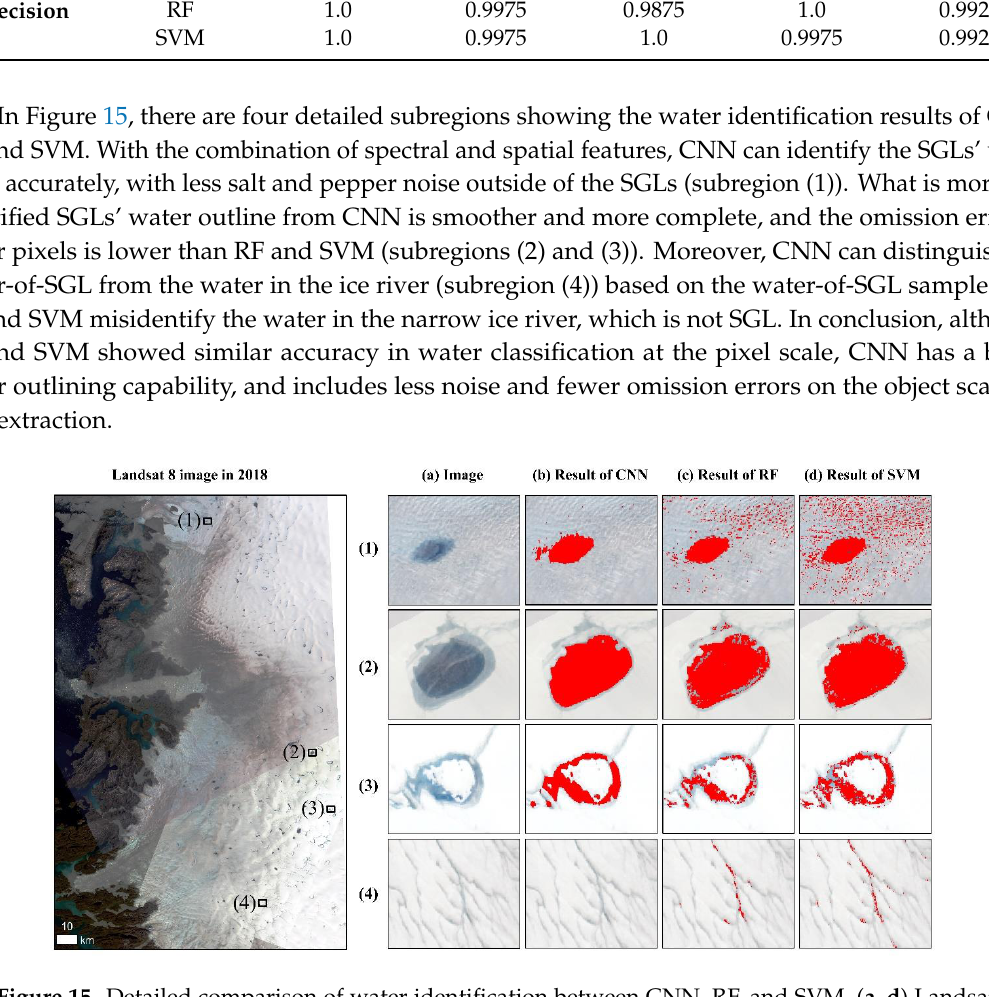
Table 6. Comparison of water identification accuracy among CNN, RF, and SVM.